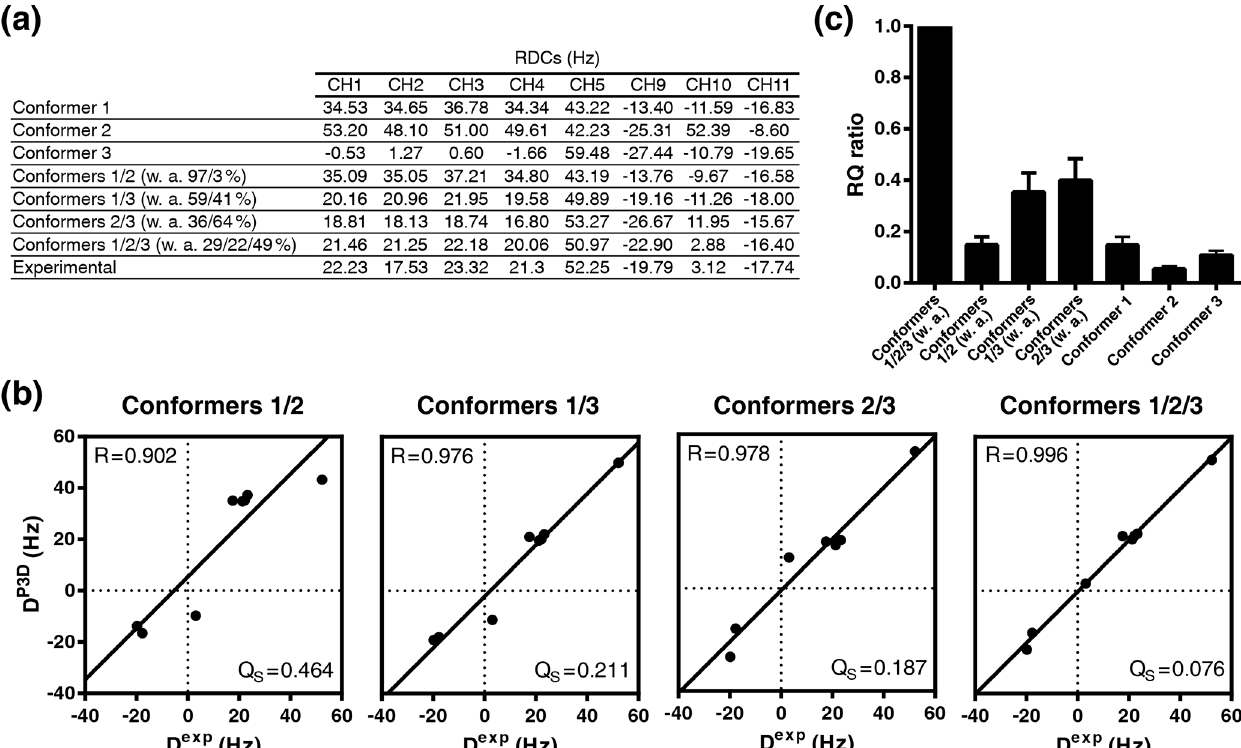
Figure 6. P3D-based refinement of the conformational ensemble of sucrose. (a) List of P3D-calculated RDCs for the three conformers together with the average weighted RDCs from the RQ maximization for two- and three-conformer ensembles and the experimental RDCs. (b) Correlation between the experimental RDCs. When all RDCs are considered, we get R = 0 . 926 for the average with 0.806, 0.615, and 0.838 respectively for each conformer. The obtained populations (26%/20%/54%) are very similar to the ones obtained with the one-bond CH RDCs only. (D exp ) and the P3D-calculated RDCs for the weighted average of the RQ maximization for two- and three-conformer ensembles. (c) RQ ratios of the three different conformers in reference to their weighted average as two- and three-conformer ensembles. Error bars were calculated as the propagation of R and QS errors, and these errors are calculated from the SD of 100 repetitions including noise in the